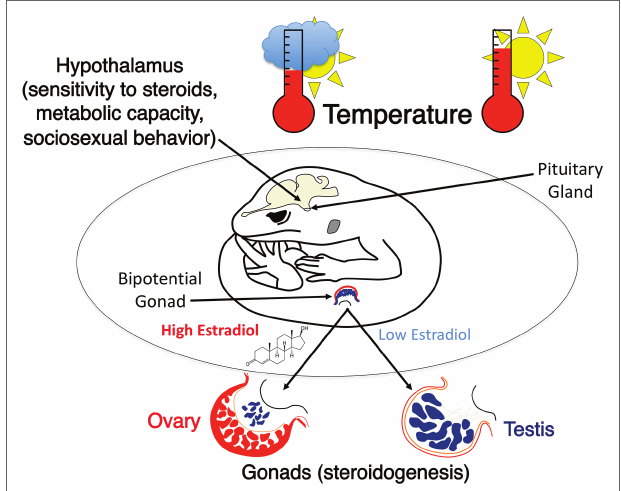
FIGURE 6 | A graphical illustration of temperature effects on neural and gonad development in the leopard gecko. Incubation temperature determines sex and causes intrasexual variation in sociosexual behaviors. These differences in behavior are correlated with significant differences in metabolic capacity within specific hypothalamic nuclei as well as differences in sensitivity to sex steroids that activate sociosexual